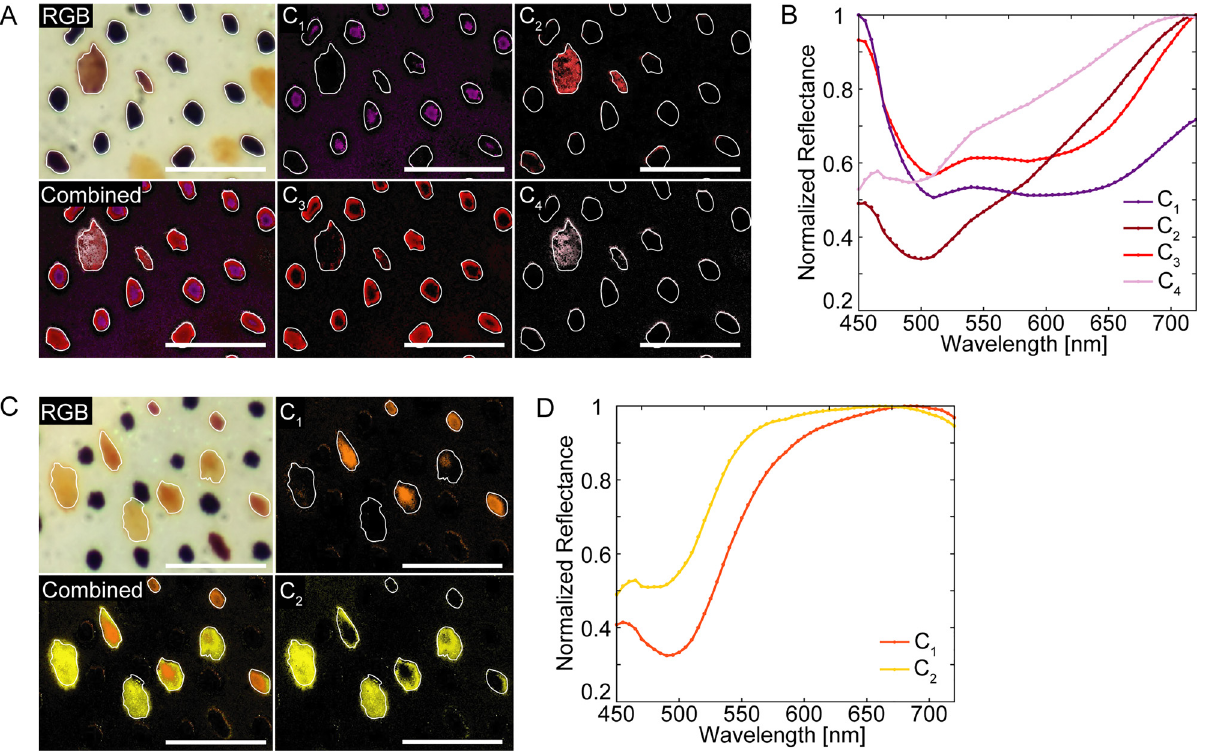
Figure 3: Multispectral analysis of pigments density in light and dark chromatophores. (A) Low magnification multispectral map of aged excised O. bimaculoides skin in the spectral range 450 – 720 nm. The RGBimage is spectrally unmixedinfalse-colorimagesthatshowthespatialdistributionofthedarkchromatophores( C 1 – C 4 ),ashighlightedbythewhiteoutlinemask, and that can be used to generate the combined multispectral map (Combined). (B) Corresponding normalized re fl ectance spectra of the dark chromatophores. (C) Low magni fi cation multispectral map of aged excised O. bimaculoides skin in the spectral range 450 – 720 nm. The RGB imageisspectrallyunmixedinfalse-colorimagesthatshowthespatialdistributionofthelightchromatophores( C 1 – C 2 ),ashighlightedbythe white outlinemask, andthat can be usedto generatethe combined multispectral map (Combined). (D)Corresponding normalizedre fl ectance spectra of the light chromatophores. Scale bar: 200